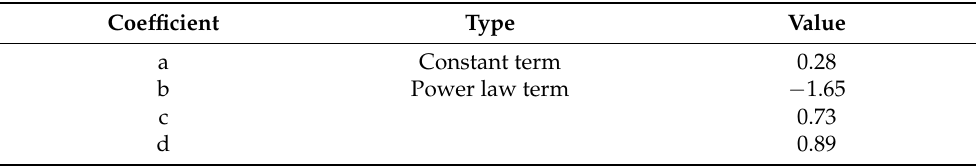
Table 6. Non-linear regression coefficients of the empirical power law kinetic